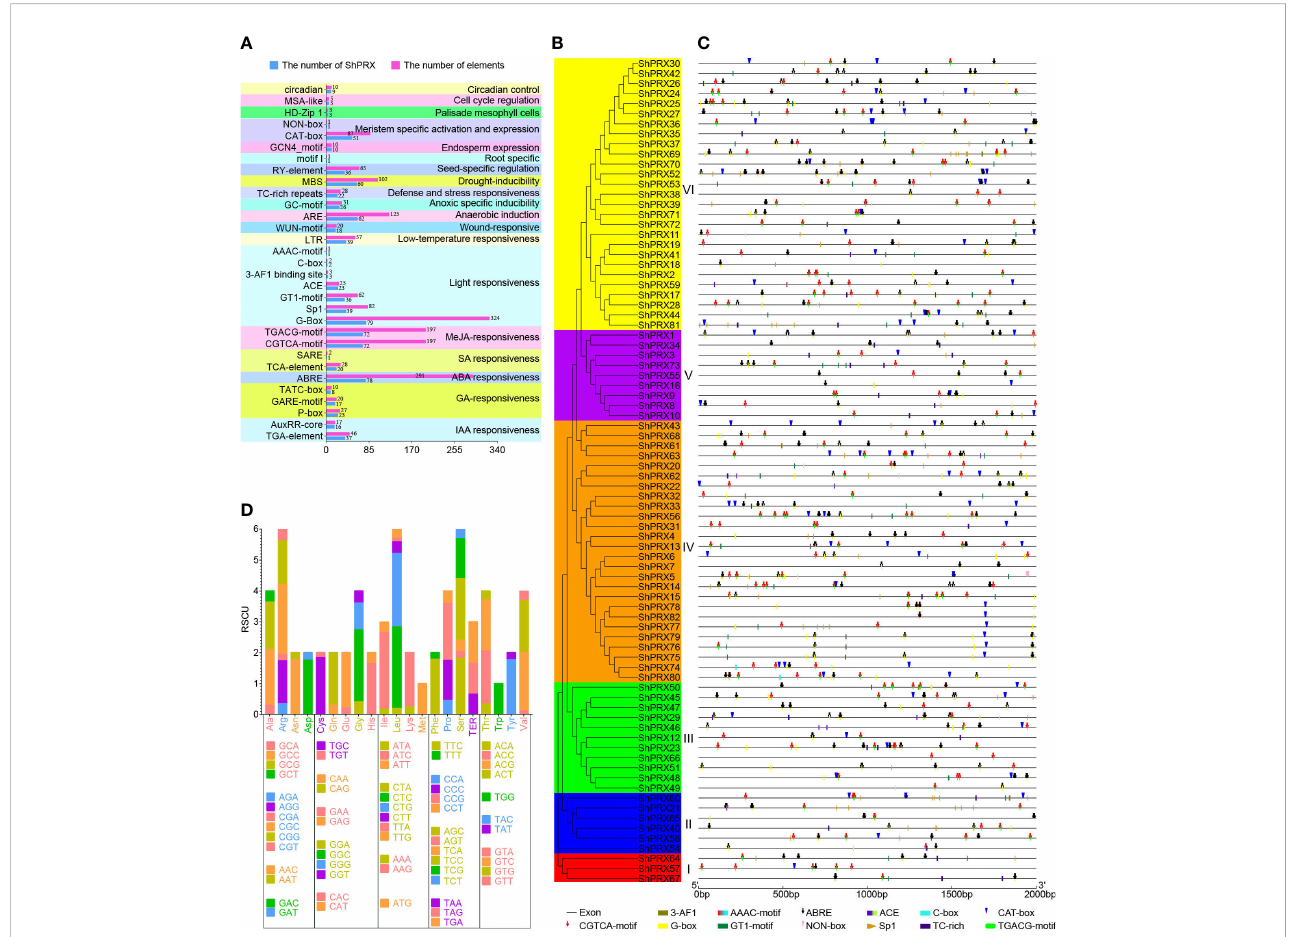
FIGURE 4 Analysis of cis-acting elements and codon usage bias of the PRX gene family in sugarcane. (A) The analysis of cis-acting elements of the PRX gene family in sugarcane. (B) The phylogenetic tree of the ShPRX proteins. (C) The analysis of cis-acting elements involved in the ABA, MeJA, light, defense, and stress responsiveness, meristem-speci fi c activation, and expression in the PRX gene family of each group. (D) The codon usage bias analysis of PRX gene family in